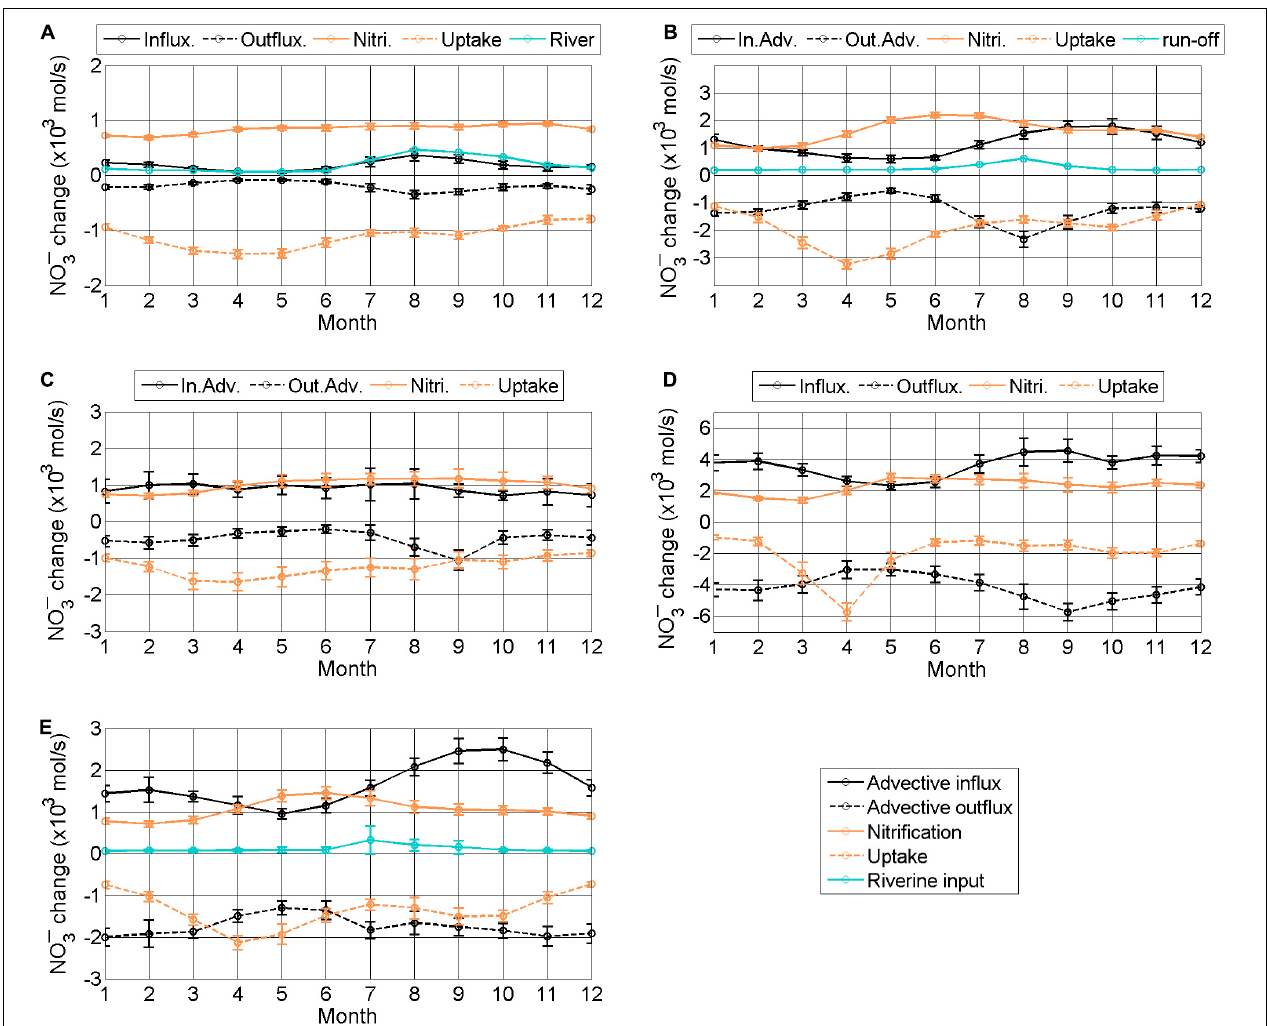
FIGURE 13 | Monthly mean change in NO 3 − ( kmol s − 1 ) by advection and biological processes in different subregions averaged for the period 2006–2019. (A–E) represent subregions BS, nYS, swYS, scYS, and seYS, respectively (see Figure 11A ). Black solid and dashed lines indicate total inward and outward NO 3 − fluxes via currents, respectively. Orange solid and dashed lines denote nitrification and uptake by phytoplankton, respectively. The cyan line denotes NO 3 − flux via riverine input. BS, Bohai Sea; nYS, northern Yellow Sea; swYS, southwestern Yellow Sea; scYS, southcentral Yellow Sea; seYS, southeastern Yellow